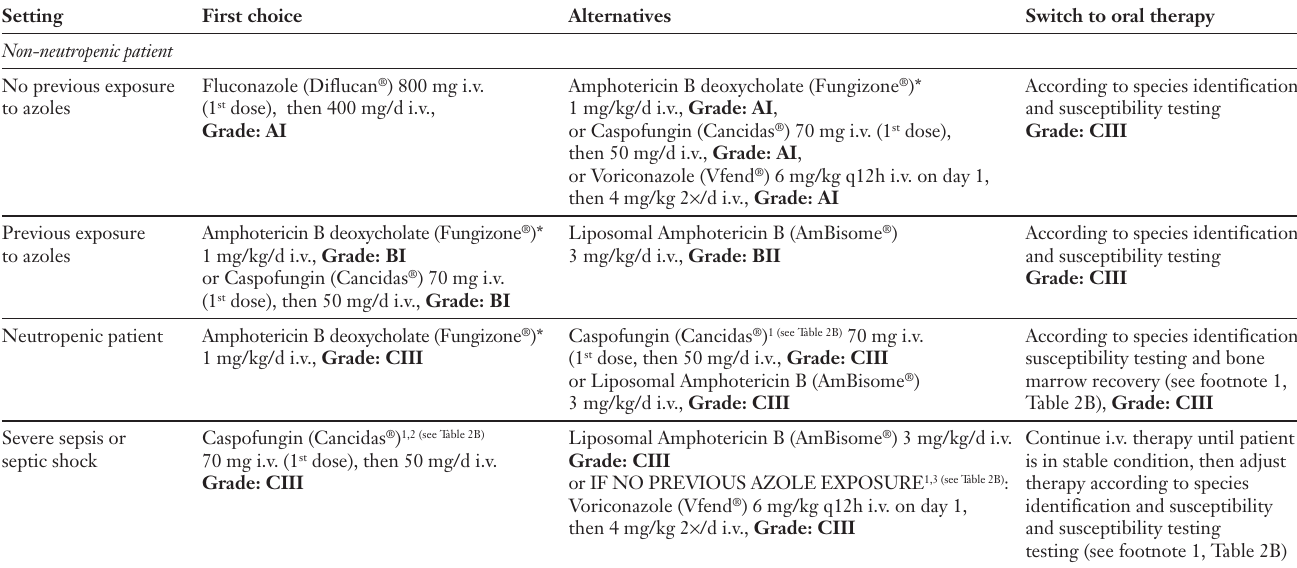
Empirical therapy for Candida bloodstream infections.